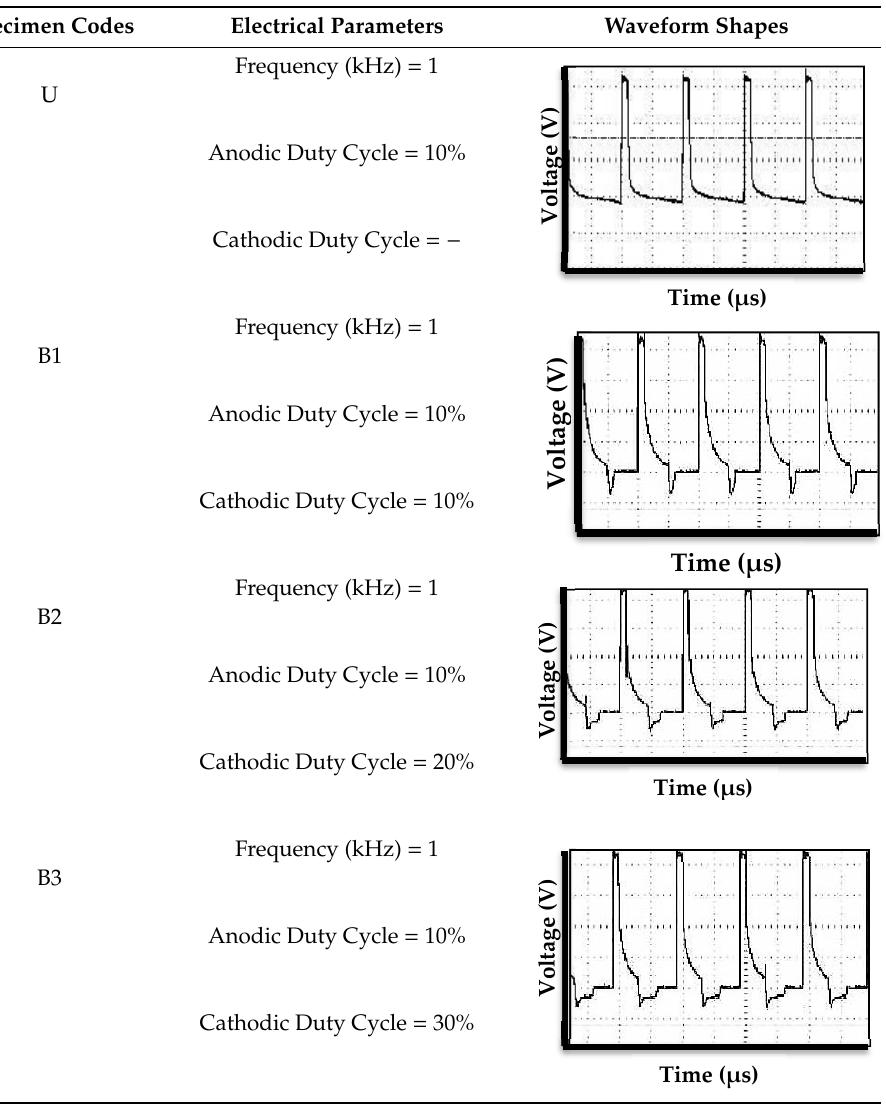
Table 1. Sample codes, waveform shapes and electrical parameters applied for plasma electrolytic oxidation (PEO) process.